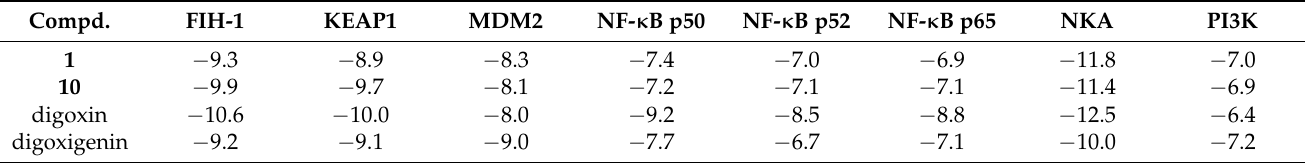
Table 2. Docking scores (minimal, kcal/mol) of 1 , 10 , digoxin, and digoxigenin calculated from their binding to FIH-1, KEAP1, MDM2, NF- κ B, NKA, and PI3K.